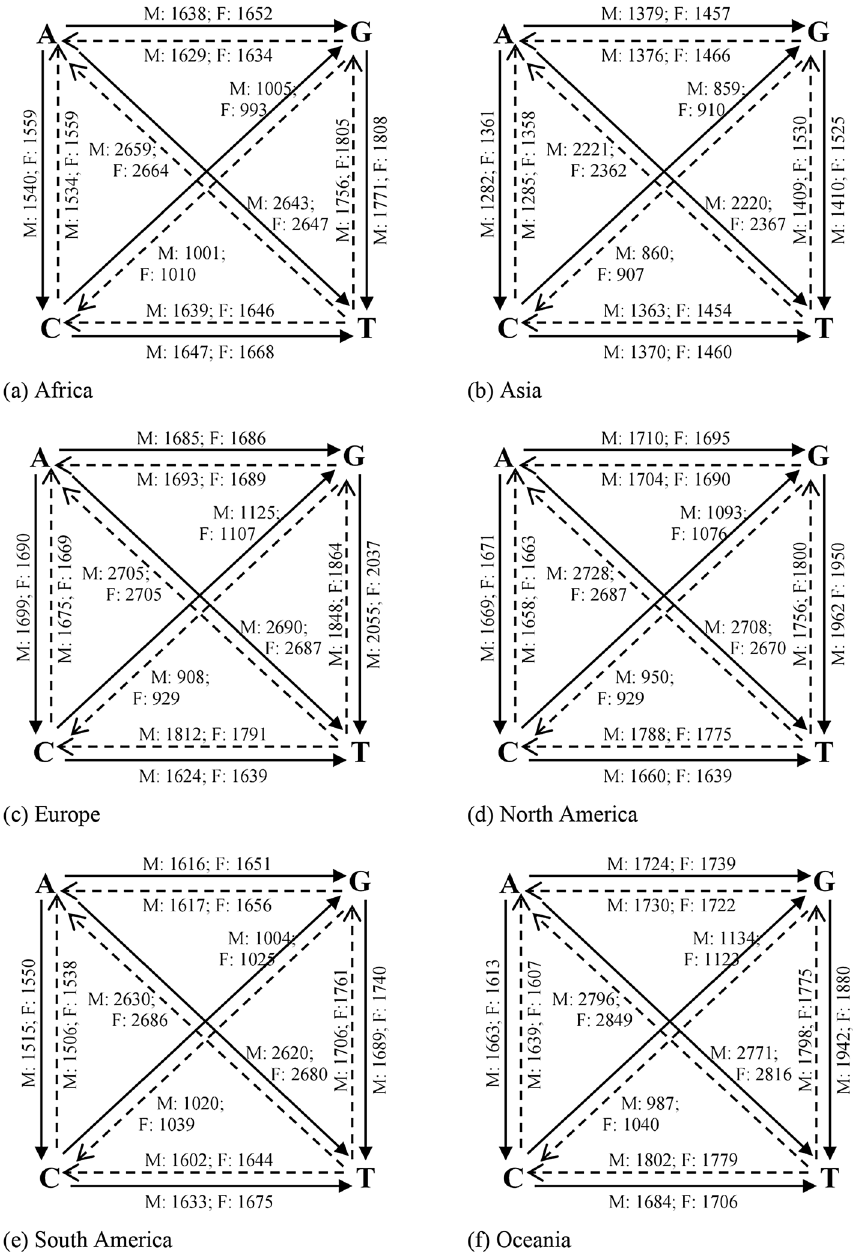
Figure 3. Base pair changes in SARS-CoV-2 genomes for male and female isolates. Thick arrows indicate transitions, while dotted arrows represent transversions. Inscriptions on/near the arrows represent transition frequencies for male and female